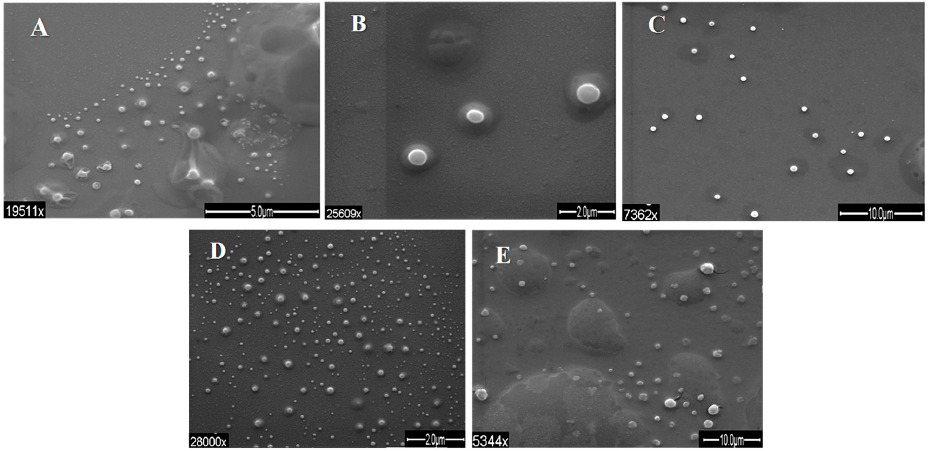
Figure 6. SEM images of post optimization beads morphology from samples ( A – E ) particles. Letters of images correspond to the same sample letter.